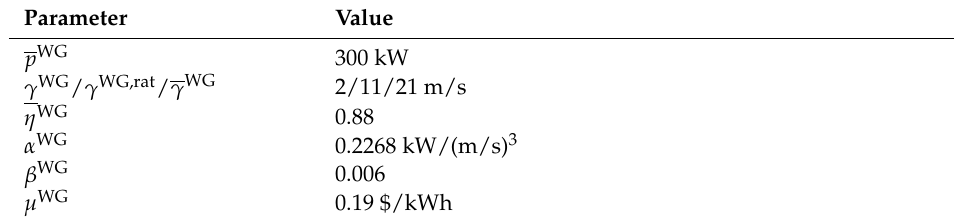
Table 4. WG system data [26].